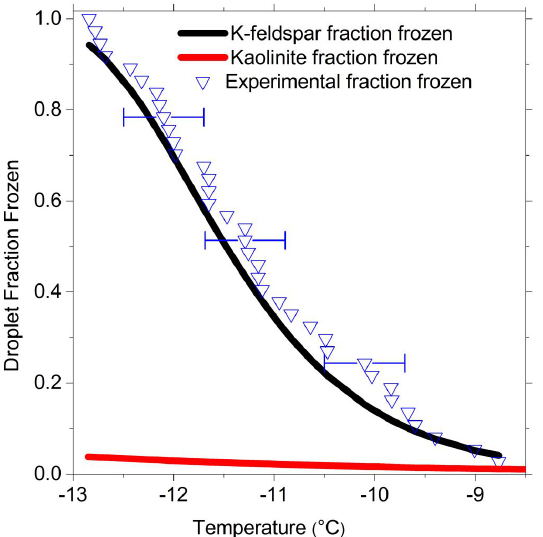
Figure 8. Fraction frozen for water droplets contaminated with 0.1wt% K-feldspar and 1wt% kaolinite. For comparison the ex- pected fractions calculated from parameterisations for n s for rele- vant amounts of each material are included. In each droplet there is approximately 60 times more surface area of kaolinite than K-feldspar. Nevertheless, the experimental fraction frozen clearly tracks the fraction frozen calculated based upon the K-feldspar com- ponent. This demonstrates why it is important to quantify the pre- cise composition of mineral dusts for ice nucleation measurements.